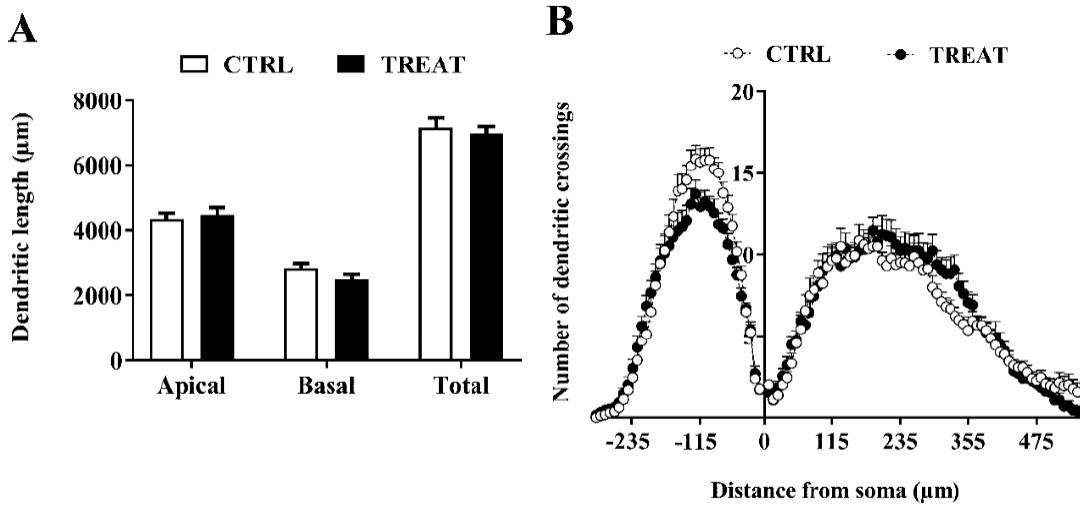
Figure 4. Morphological analysis of biocytin-stained neurons from the CA1 region of the hippocampus. Creatine maternal supplementation does not affect neuronal morphology in adult progeny. ( A ) Dendritic length of the CA1 pyramidal cells. ( B ) Scholl analysis plot showing numbers of dendritic crossings along the Scholl rings as a function of distance from the soma. Distributions of both basal and apical dendritic crossings do not result in significant differences between the two groups, two-way ANOVA with Distance from soma and Treatment (CTRL vs. TREAT) as independent variables while the litter was considered as a blocking factor; CTRL: n = 16 neurons; TREAT: n = 13 neurons. CTRL = 5 rats; TREAT = 5 rats.